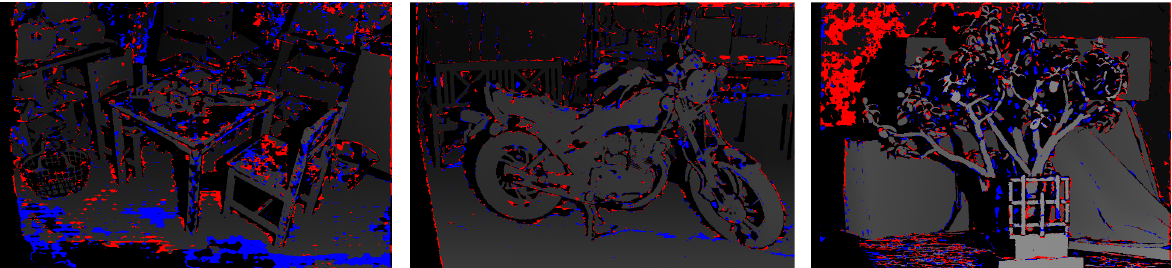
Figure 4. Disparity maps of the suggested method (from left to right: Playtable , Motorcycle and Jadeplant stereo pairs). Pixels in blue indicate errors of SGM algorithm which do not exist in our method; pixels in red depict errors of our method not present in